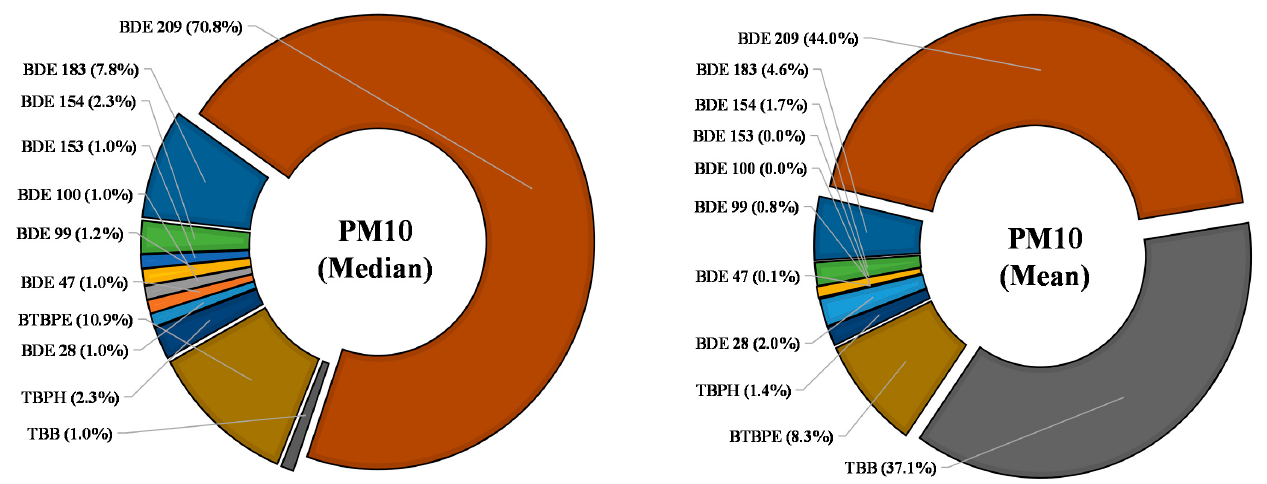
Figure 1. Profile of studied BFRs with median and mean values found in indoor PM 10 from Saudi children’s room.